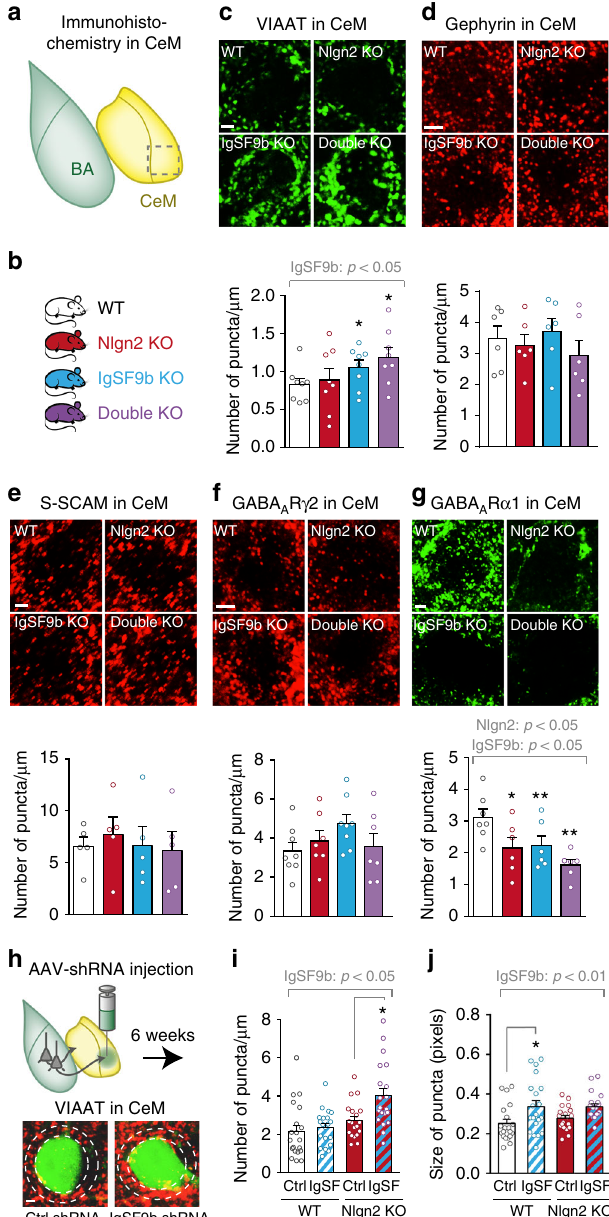
Fig. 6 IgSF9b deletion increases VIAAT puncta in the CeM. a , b Schematic diagram showing location of immunohistochemistry analysis in the CeM ( a ) and genotypes assessed ( b ). c – g Photomicrographs and quanti fi cation of the number of perisomatic puncta of c VIAAT, d gephyrin, e S-SCAM, f GABA A R γ 2 and g GABA A R α 1 in all four genotypes. Scale bar, 2 μ m. Error bars represent SEM, n = 5 – 8 mice per genotype. h Schematic diagram showing experimental design and representative photomicrographs of VIAAT puncta surrounding GFP-positive neurons in the CeM of Nlgn2 KO mice injected with control shRNA (left image) or IgSF9b shRNA (right image). Scale bar, 2 μ m. i , j Number ( i ) and size ( j ) of VIAAT puncta in WT + control shRNA (white), WT + IgSF9b shRNA (white and blue striped), Nlgn2 KO + control shRNA (red), Nlgn2 KO + IgSF9b shRNA (red and blue striped). n = 20 cells/3 mice per experimental group. Statistically signi fi cant ANOVA comparisons are marked in gray at the top of the panels and are listed in Table 1. For all other ANOVA comparisons F < 1. Post-hoc analysis: * p < 0.05 relative to WT, ** p < 0.01 relative to WT, *** p < 0.001 relative to WT. Error bars represent SEM. WT, white bars; Nlgn2 KO, red bars; IgSF9b KO, blue bars; double KO, purple